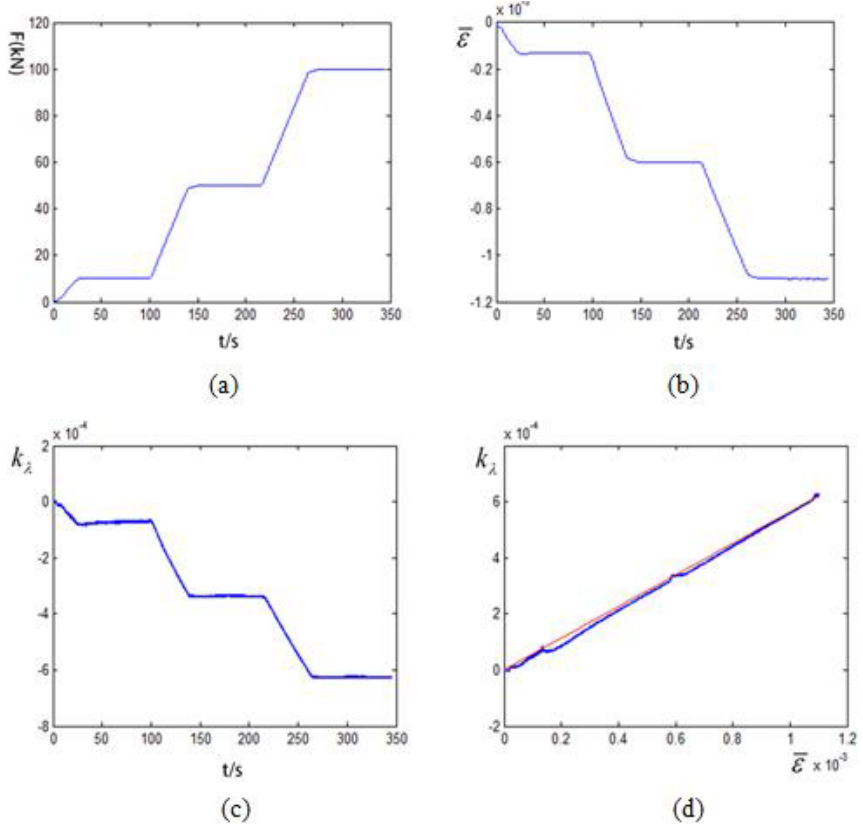
Figure 13. Schematic diagram of the data processing performed during the stress-loading process.